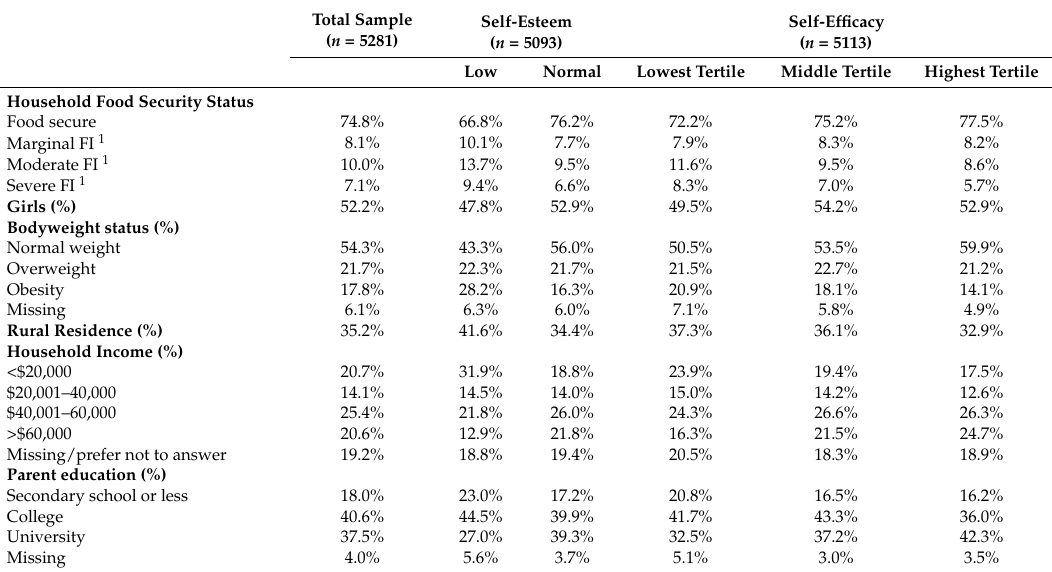
Table 1. Characteristics of grade 5 students (aged 10–11 years) in Nova Scotia, Canada by self-esteem and self-efficacy. Children’s Lifestyle and School performance Study (CLASS)